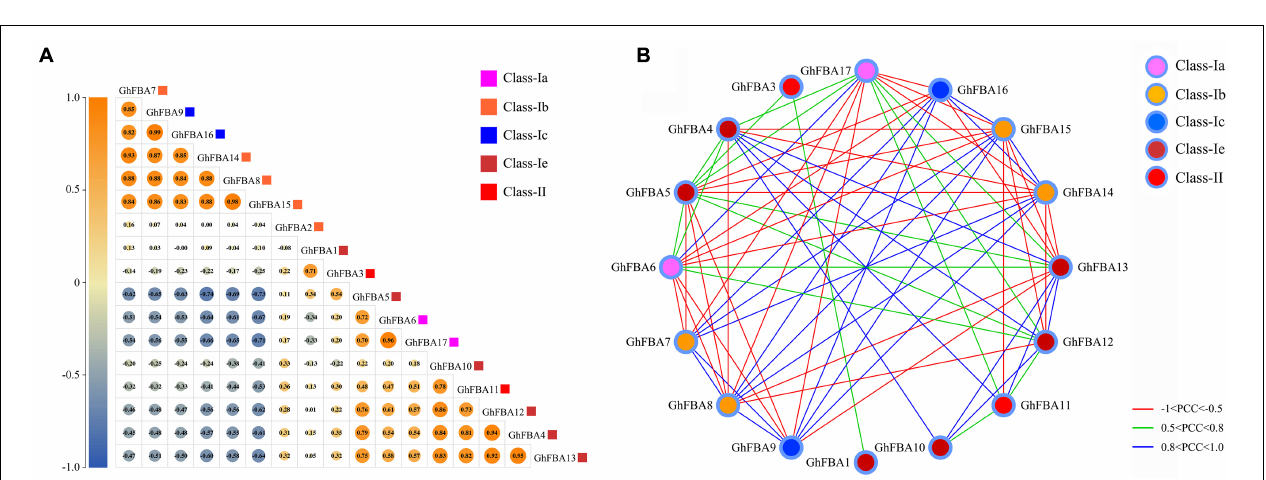
FIGURE 8 | Expression patterns of 8 selected GhFBA genes in response to phytohormone treatments. qRT-PCR was performed to analyze the relative expression levels, and GhHIS was used as a reference gene. Asterisks indicate the significant differences between treatment groups and control groups (* P < 0.05, ** P < 0.01, Student’s t -test).